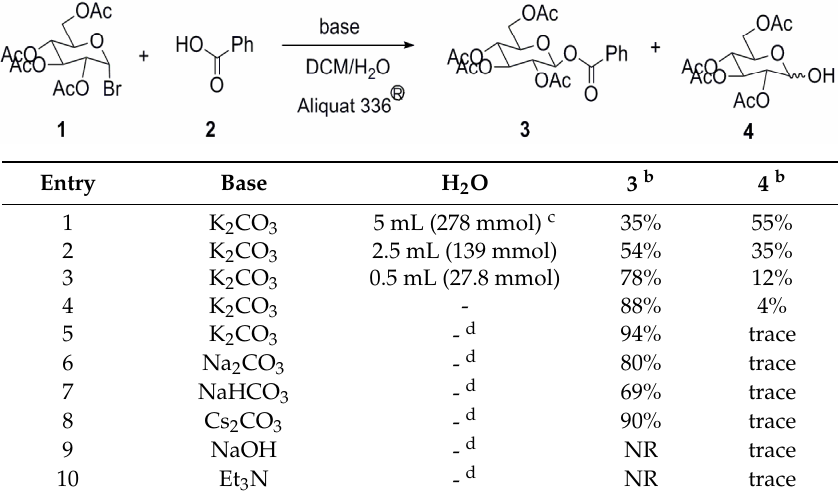
Table 1. The influence of water and the screening of base for the reaction of 1 with 2 a .